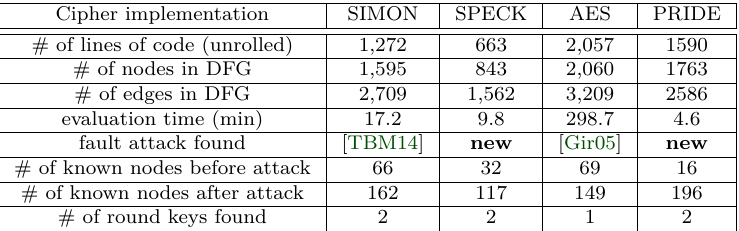
Table 4: Evaluation by TADA on different